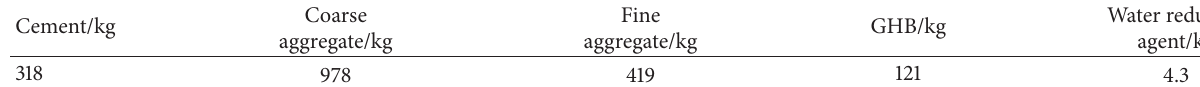
Table 6: Mixing design of lightweight aggregate concrete.